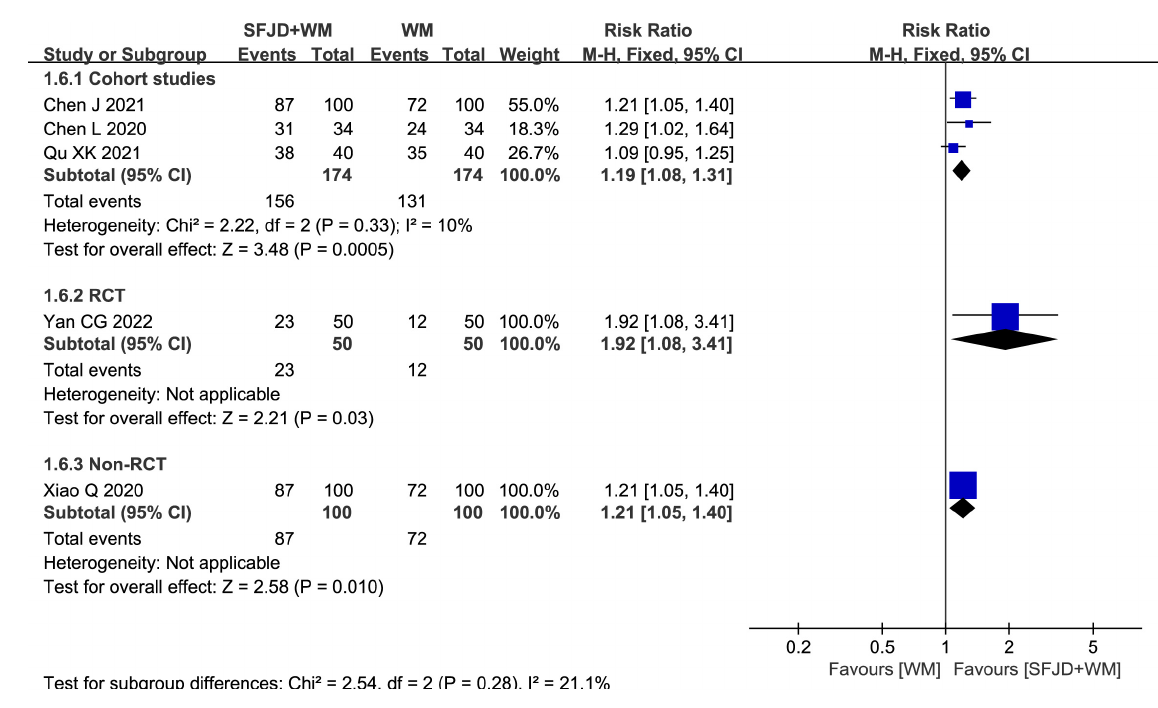
FIGURE6 Meta-analysis regarding the CT improvement rate between SFJD + WM and WM groups among COVID-19 cases.